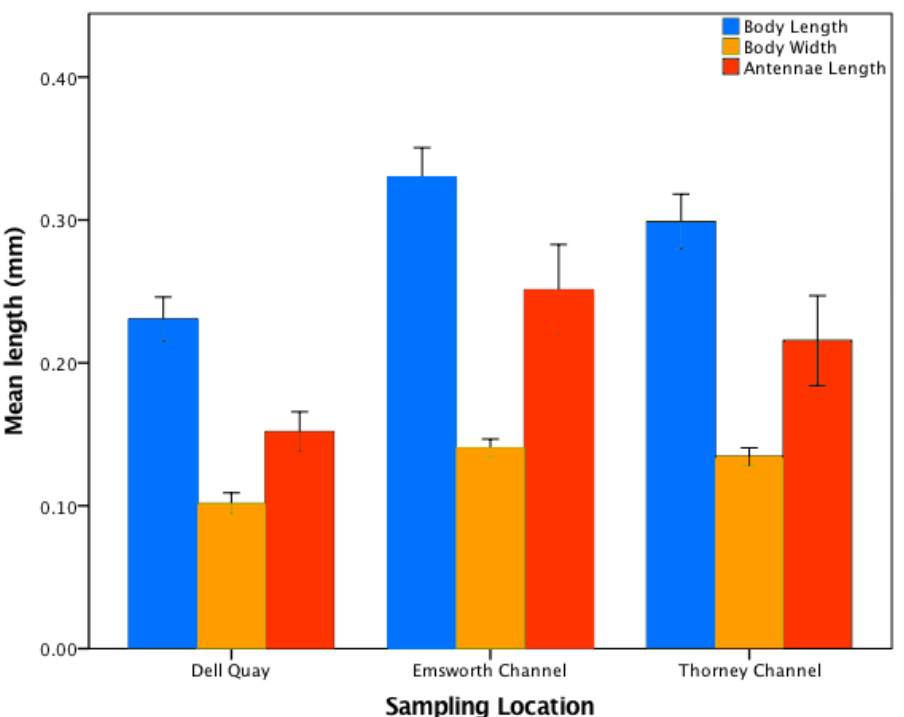
Figure 3. Mean (± SE) body length, width and antennae length of Temora longicornis samples from three sampling localities in Chichester Harbour, UK (n = 30 per